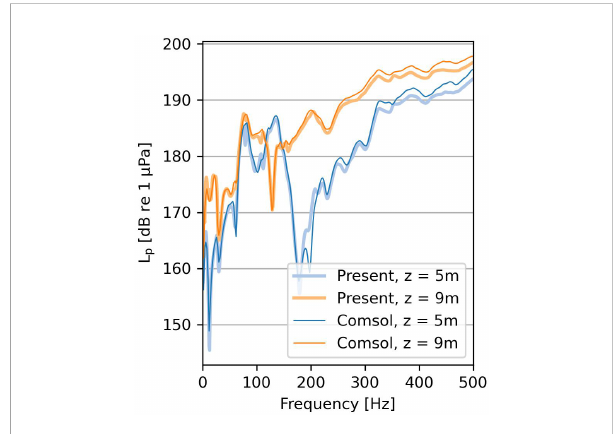
10 m between Comsol (dark colors) and the present model (light colors) for a harmonic load of 1 MN.